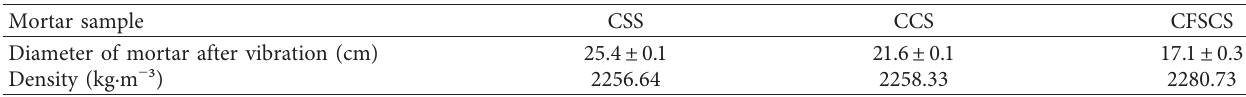
Figure 2: Nyquist plot of Randles type. R 0 is the resistance of pore solution, and R 1 is the resistance of gel hydration products. Table 4: Fluidity and density of mortar samples.